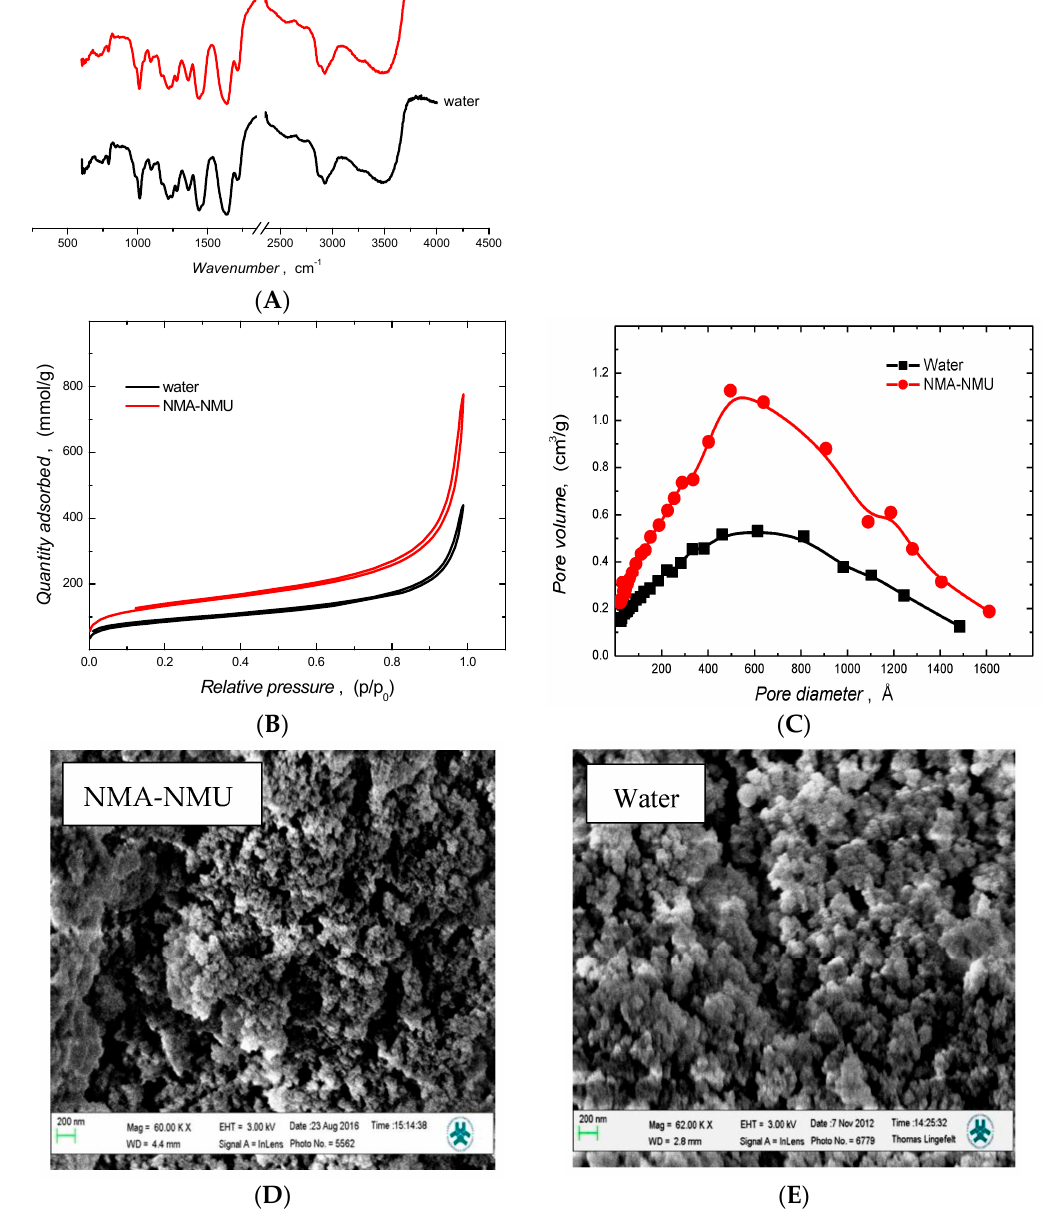
Figure 2. ( A ) Infrared spectra. ( B ) Nitrogen adsorption-desorption isotherms and ( C ) pore distribution plot (desorption) observed from BET adsorption isotherm experiments. ( D,E ) Scanning electron micrographs, respectively, of MAA–BAP copolymer synthesized in NMA–NMU eutectic system and